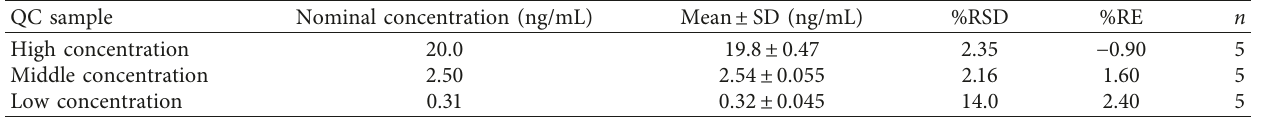
Table 2: Intra-assay accuracy and precision of the applied analytical